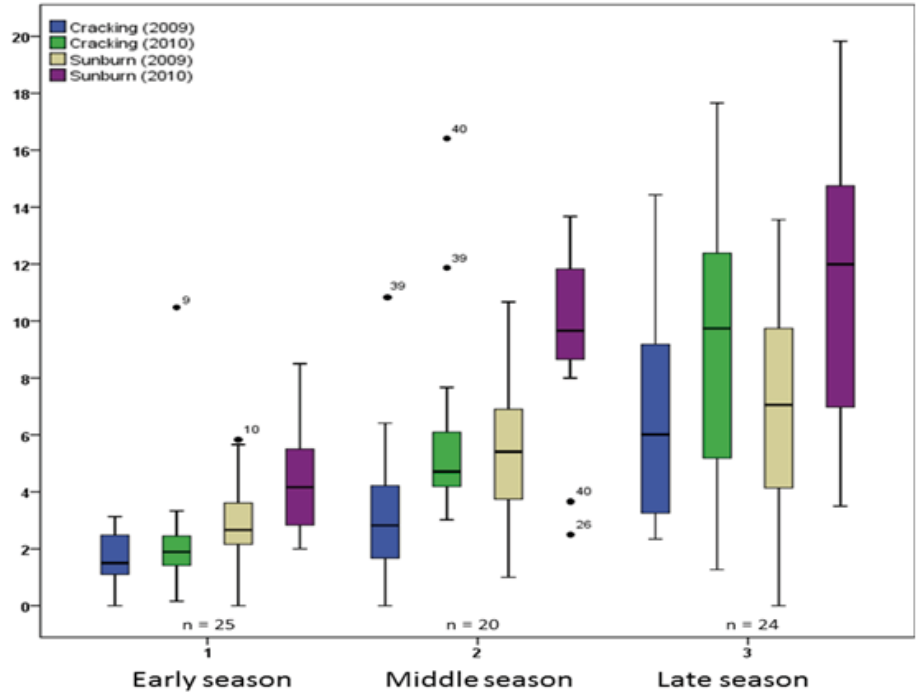
Fig. 4: Box-Plot diagram of genotypes based on cracking and sunburn values during two years (n= number of genotypes in every